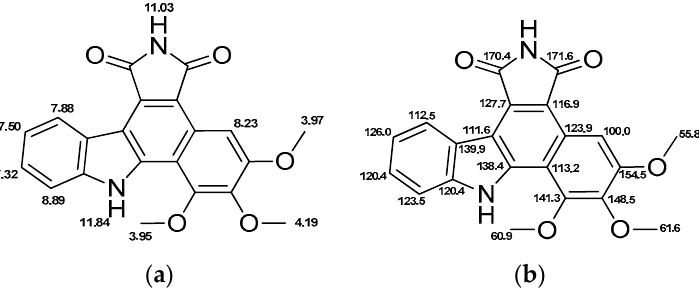
Figure 10. Chemical structure of 3 and relevant NMR shifts for ( a ) 1 H-NMR; and ( b ) 13 C-NMR.